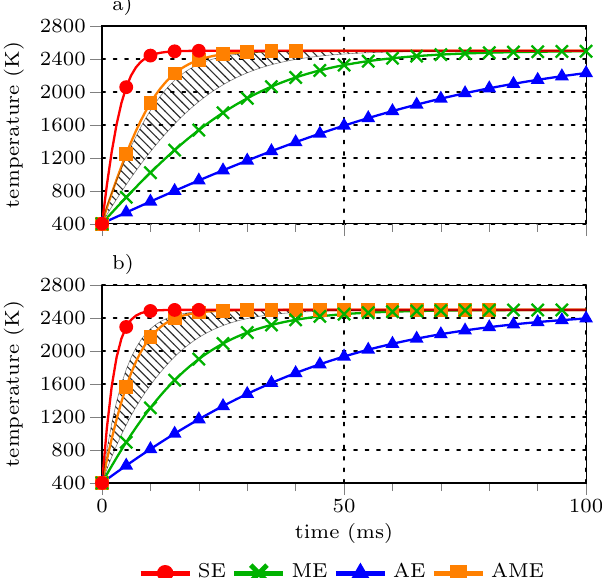
Figure 6. Comparison of cluster and equivalent sphere temperature profiles ( a ) 0.5 m/s ( b ) 13 m/s relative velocity. Hatched areas represent cluster temperature profiles. SA, ME, AE, and AME are the size, mass, surface area, and surface area and mass equivalent case,